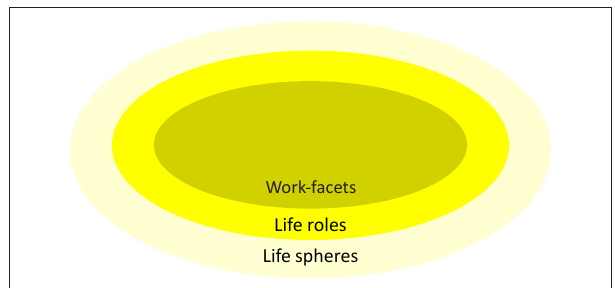
FIGURE 1: The proposed onion model for the formation of